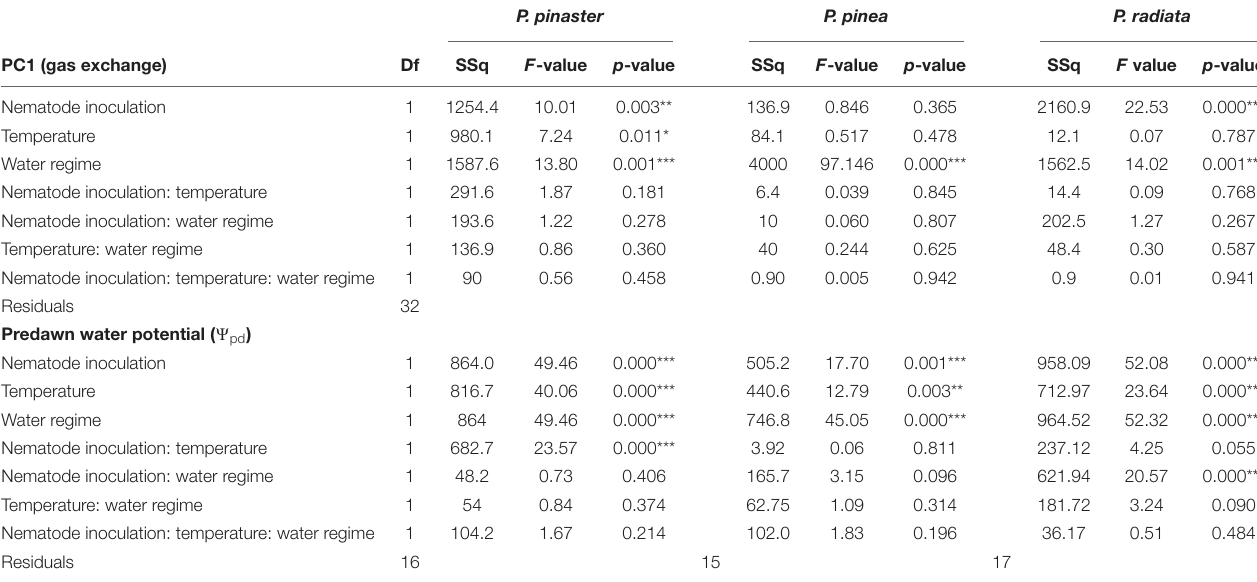
TABLE 1 | Effects of temperature (25 ◦ C/30 ◦ C), water regimes (W – watered/WS – water stressed), Bursaphelenchus xylophilus inoculation (N − non-inoculated/N + inoculated) and their interaction on PC1 values extracted from first PCA axis, and on pre-dawn Water Potential ( (cid:57) pd